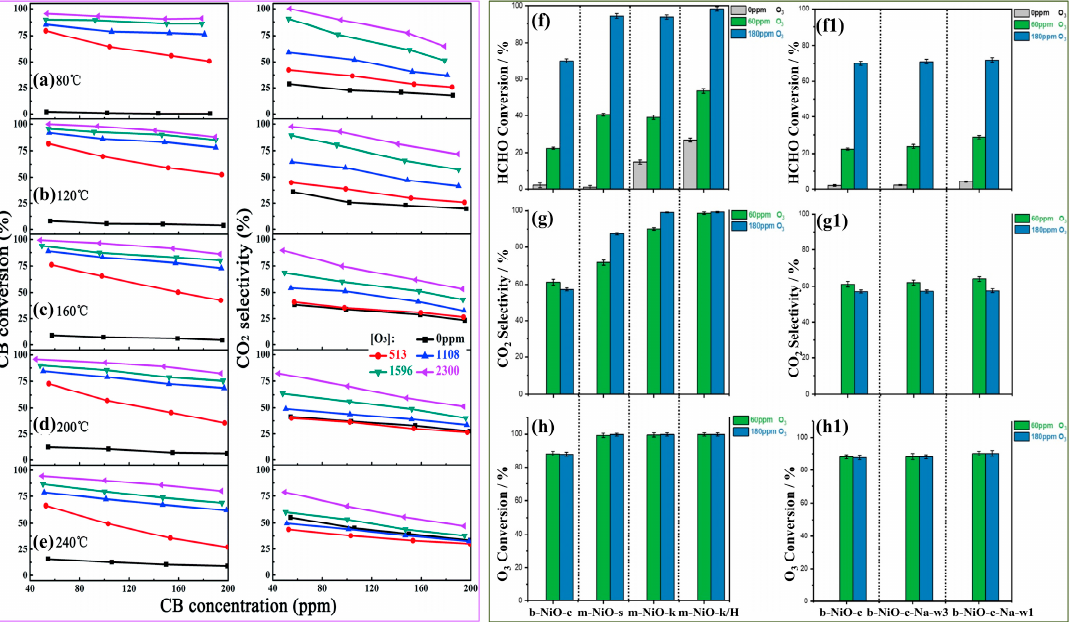
Figure 9. ( a – e ) Temperature dependence of chlorobenzene catalytic oxidation over MnO x /CNTs with and without O 3 . Reprinted with permission: Royal Society of Chemistry, 2015 [80]; ( f , f1 ) HCHO conversion, ( g , g1 ) CO 2 selectivity, and ( h , h1 ) O 3 conversion over different catalysts at room temperature. Reprinted with permission: Elsevier 2018 [71].